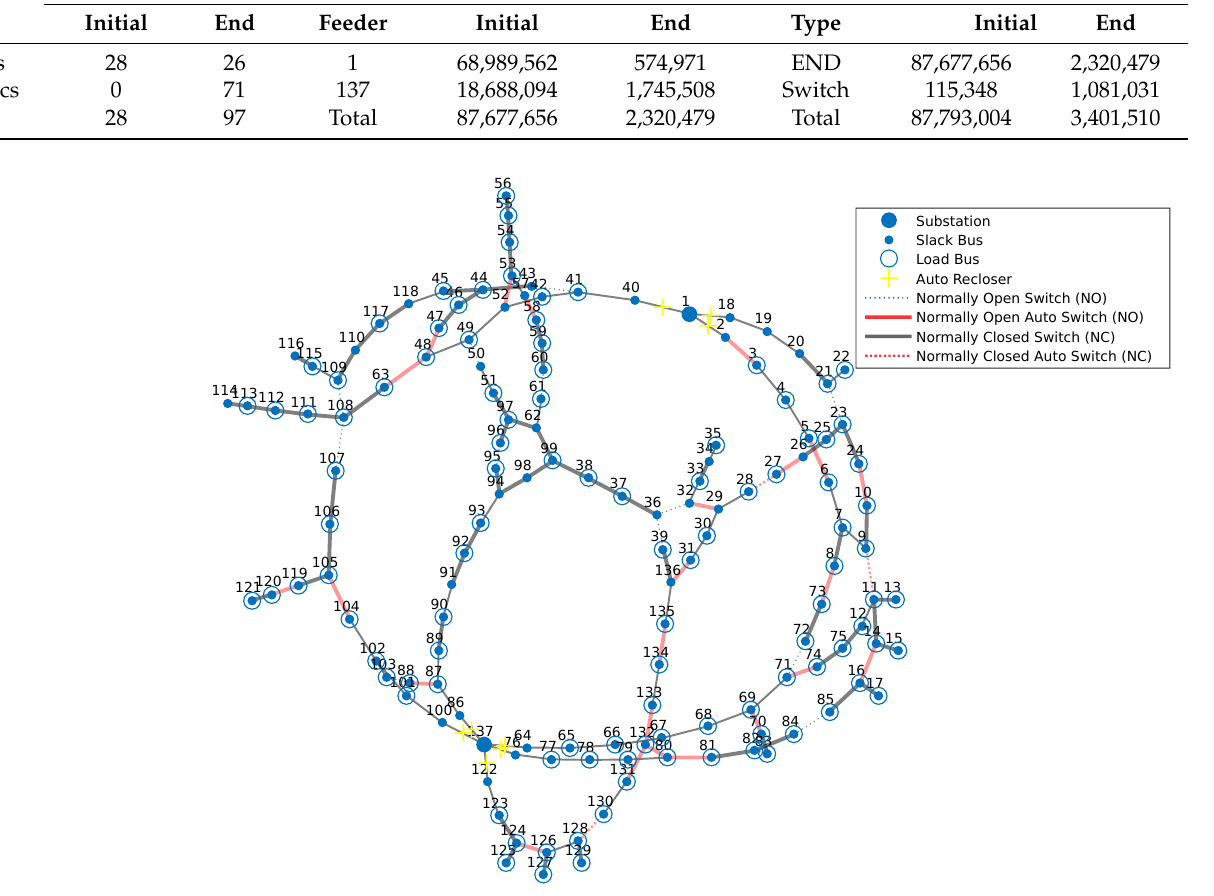
Figure 4. Optimal of the 136-bar